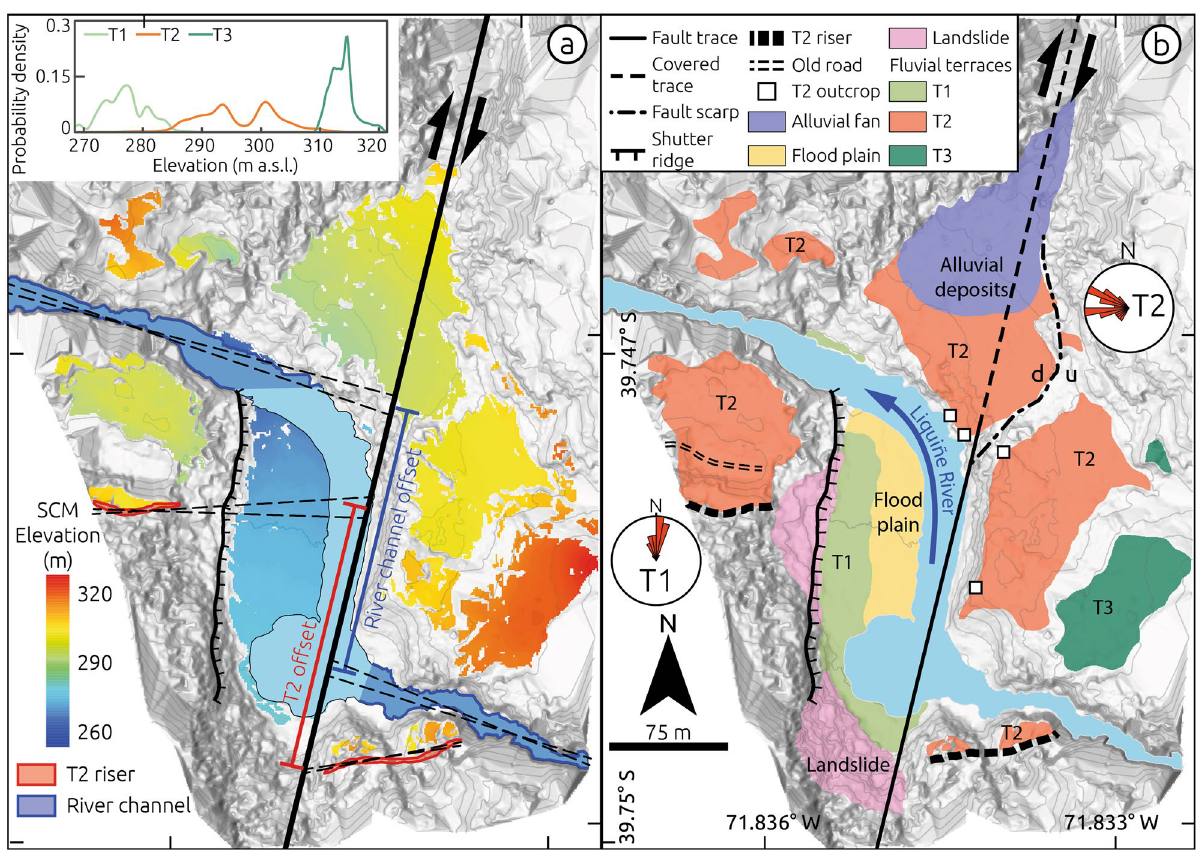
Figure 3. Tectonic geomorphology of the Liquiñe Site. ( a ) Shaded-relief Digital Terrain Model from terrestrial- laser scanner survey overlaid by colour-coded elevation of Surface Classification Model (details in methods and Supplementary Materials). The black thick line shows the Liquiñe Fault trace used to calculate fault slip by projecting two geomorphic markers (T2 and modern river channel). Stippled black lines denote extrapolation piercing lines used to estimate fault offsets. Light grey lines denote 5-m contour intervals. Inset shows elevation distribution of fluvial terraces based on SCM classification. ( b ) Geomorphic map showing distribution of fluvial terraces and structures. Rose plots show paleocurrent directions estimated from clast imbrication measurements at terraces T1 and T2. Histograms of the elevation distribution of T2 at each fault quadrant and topographic profiles across the fault and river supporting the mapping of T2 may be found in the Supplementary Materials (Fig. S4). Sense of vertical displacement across fault scarp affecting T2 denoted by u-up and